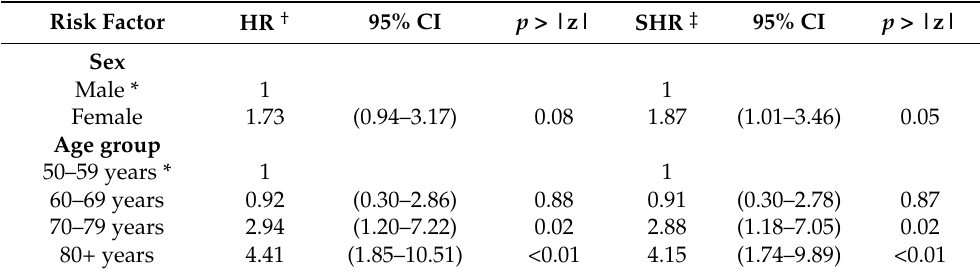
Figure 3. Relative risk of subsequent fractures among subjects with a previous fracture compared with the general population by sex (green box and square), age group (red box and circle), and index fracture site (blue box and triangle). Adjusted rate ratio estimated using Poisson regression models that included age, sex, and index fracture site as covariates. Corresponding data are presented in Supplementary Table S3. * p < 0.05, ** p < 0.01. Table 3. Hazard ratio (Cox) and subhazard ratio (Fine and Gray) of subsequent fracture events associated to sex, age, and index fracture site.